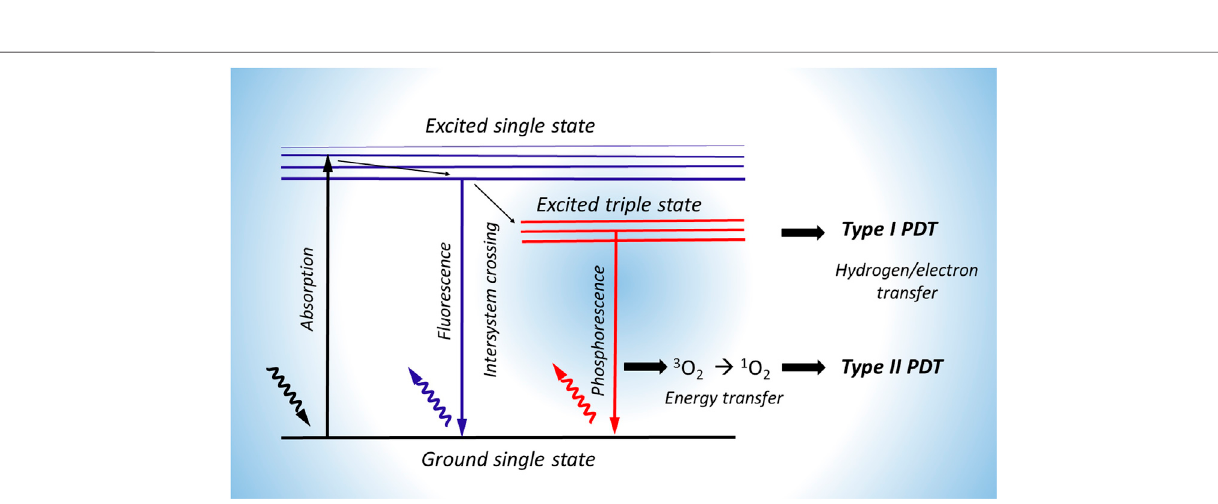
Frontiers in Physics |